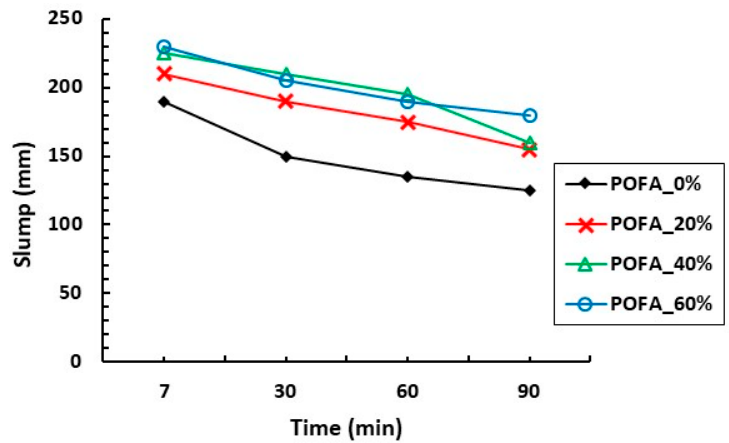
Figure 7. Influence of different percentages of cement replacement by POFA on concrete slump loss [20].